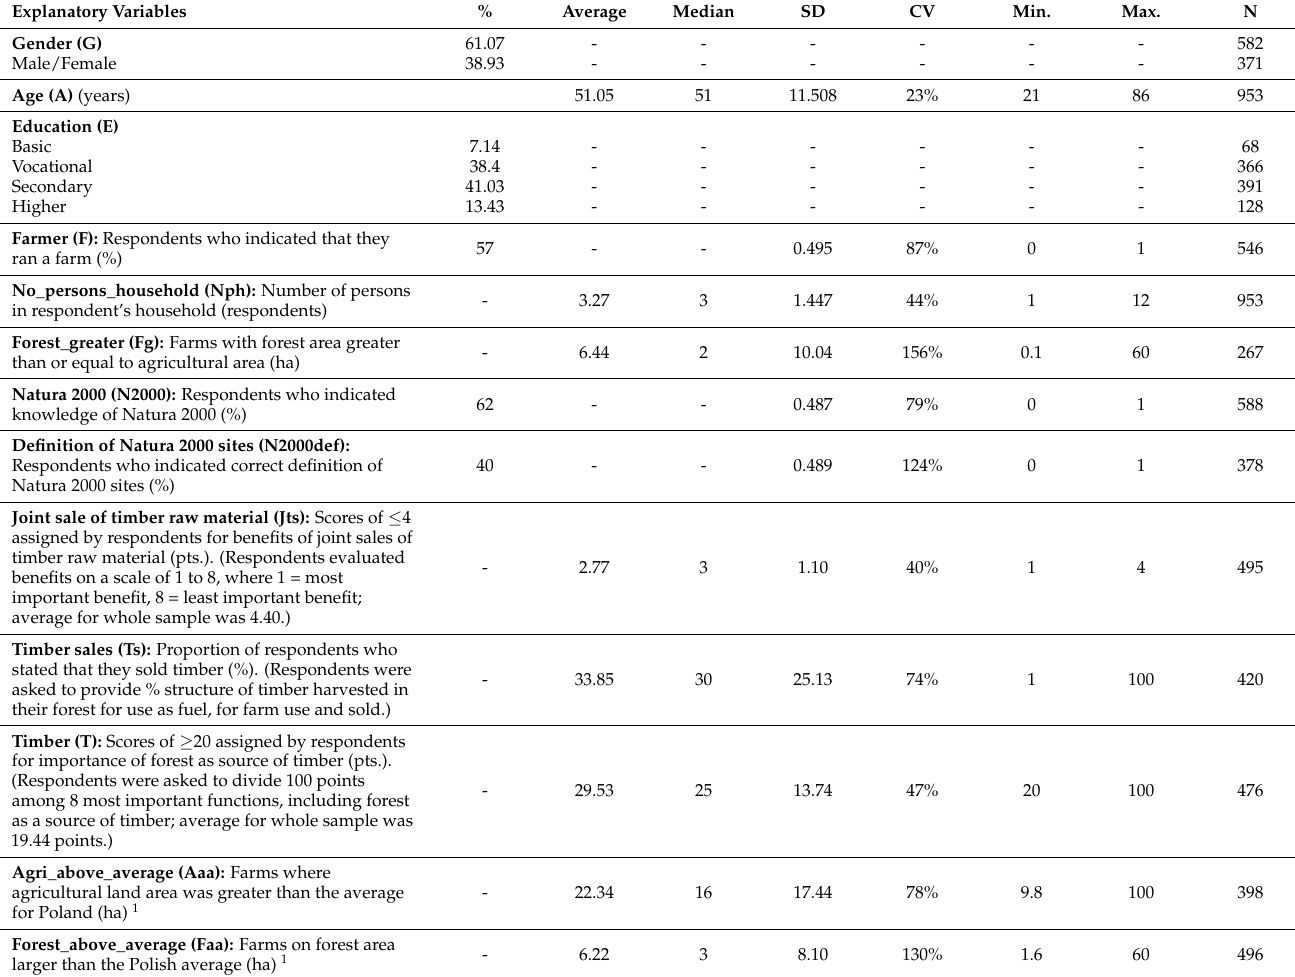
Table 2. Descriptive statistics for explanatory variables included in WTA analysis of survey reScheme 2019. on random representative nationwide sample of forest owners (farmers). SD, standard deviation; CV, coefficient of